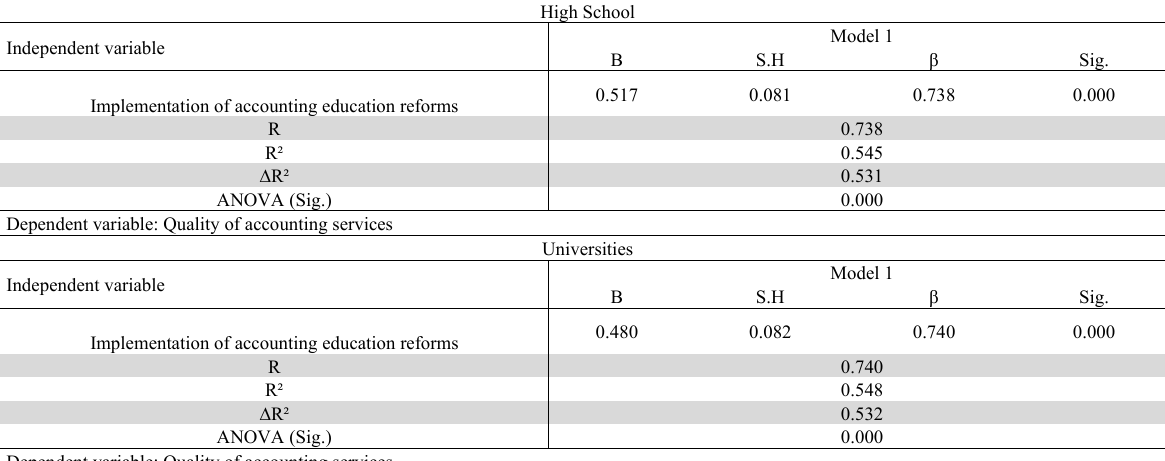
The summary of regression